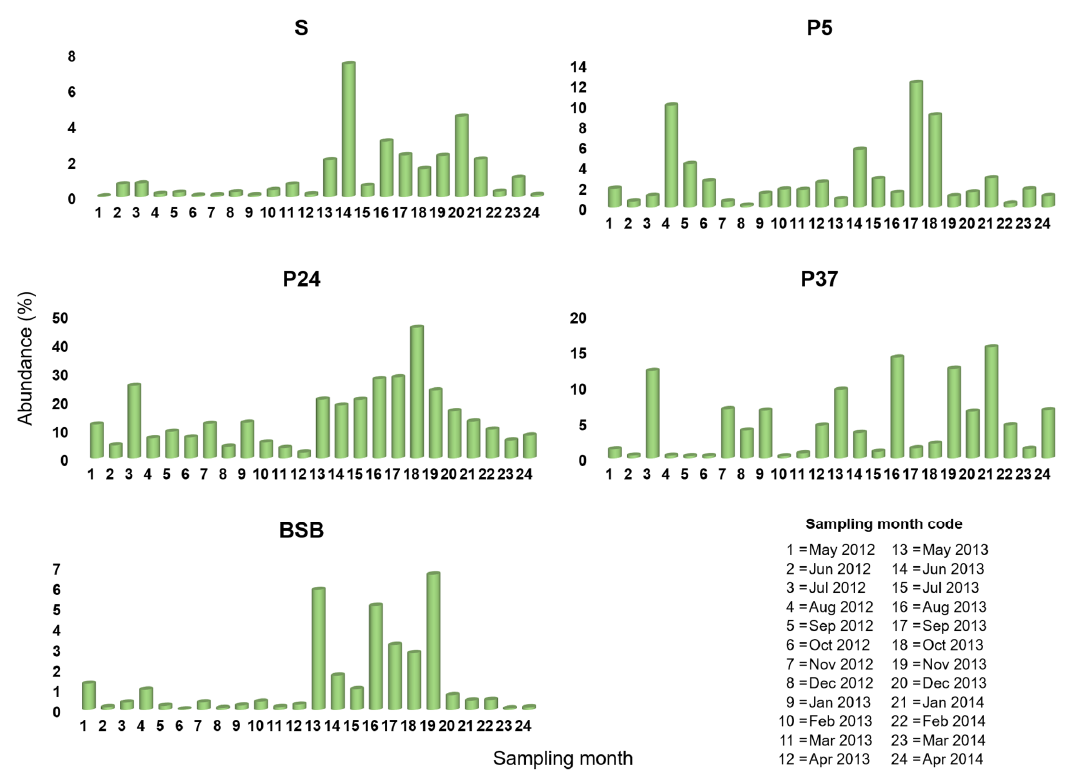
Microorganisms 2022 , 10 , x FOR PEER REVIEW Figure 4. Occurrence of OTU 2 among the ST sampling sites in the period May 2012–April 2014.